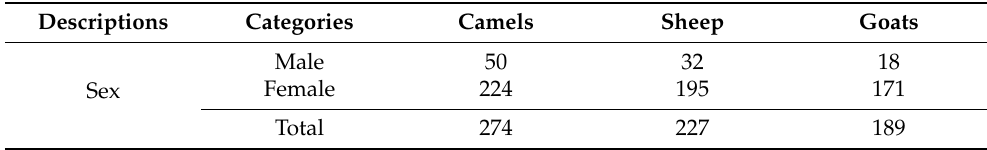
Table 1. Details of animals’ sex, age, and locality.